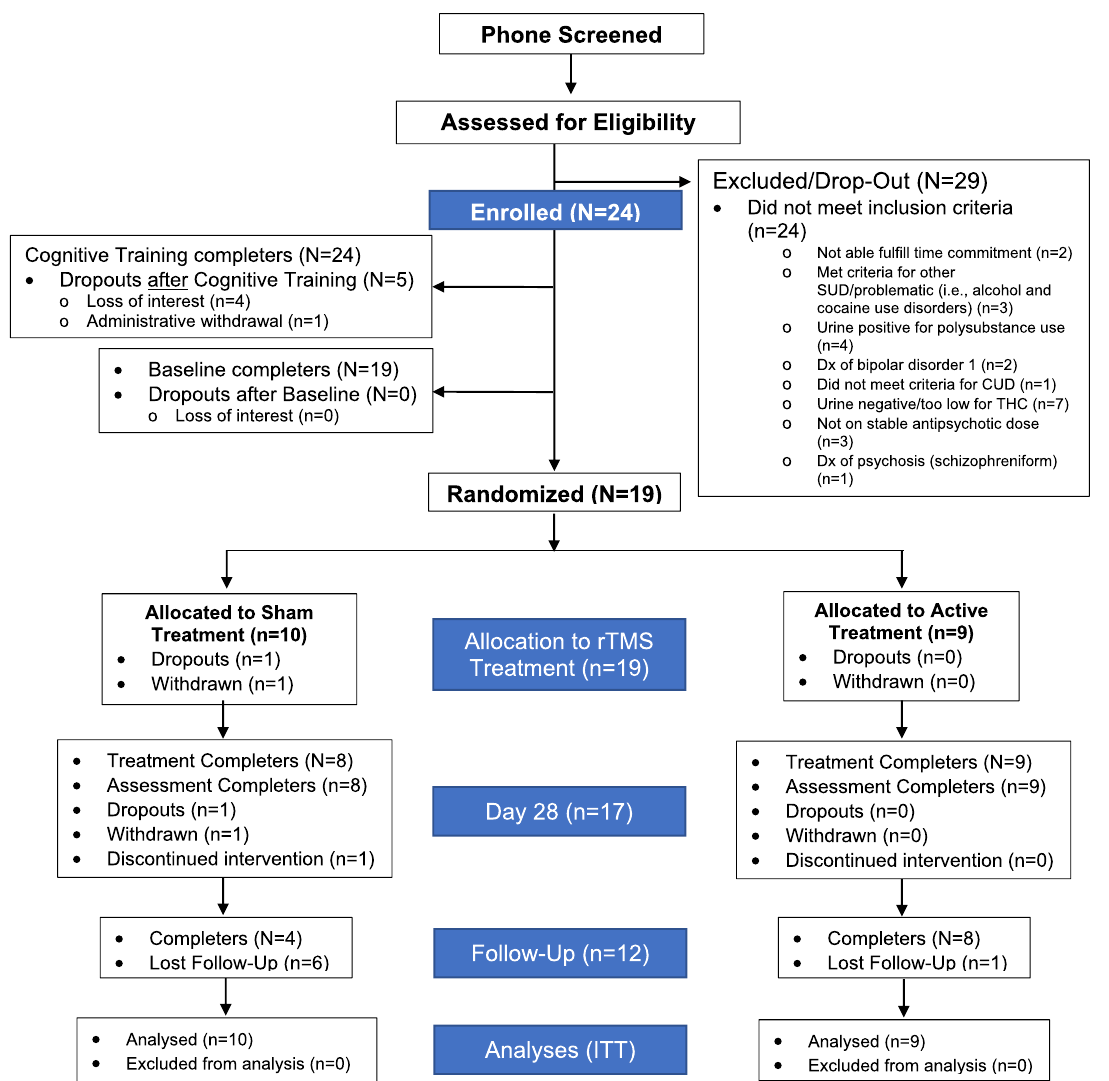
Fig. 1 CONSORT Diagram. CONSORT diagram for all participants involved in the study from the fi rst point of contact via phone-screen to randomization, follow-up, and analysis. Abbreviations: CONSORT, consolidated standards of reporting trials; dx, diagnosis; ITT, intention-to- treat analysis; SUD, substance use